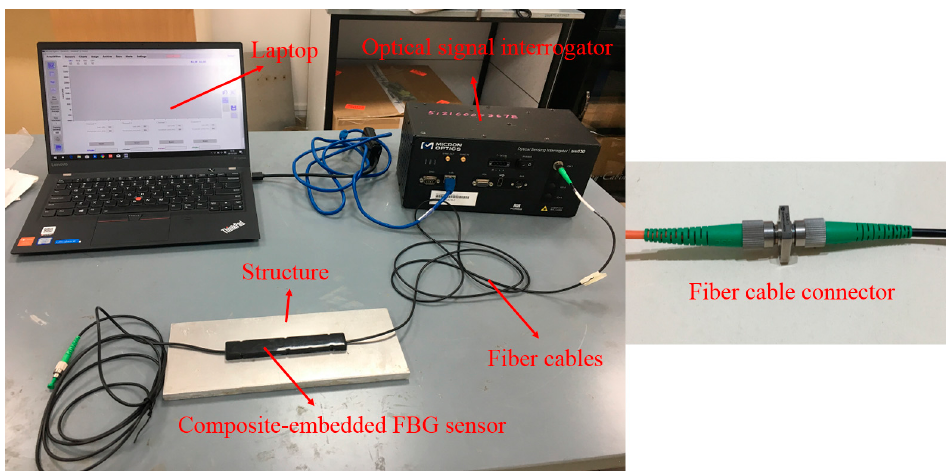
Figure 15. FBG monitoring system based on a composite embedded FBG sensor.